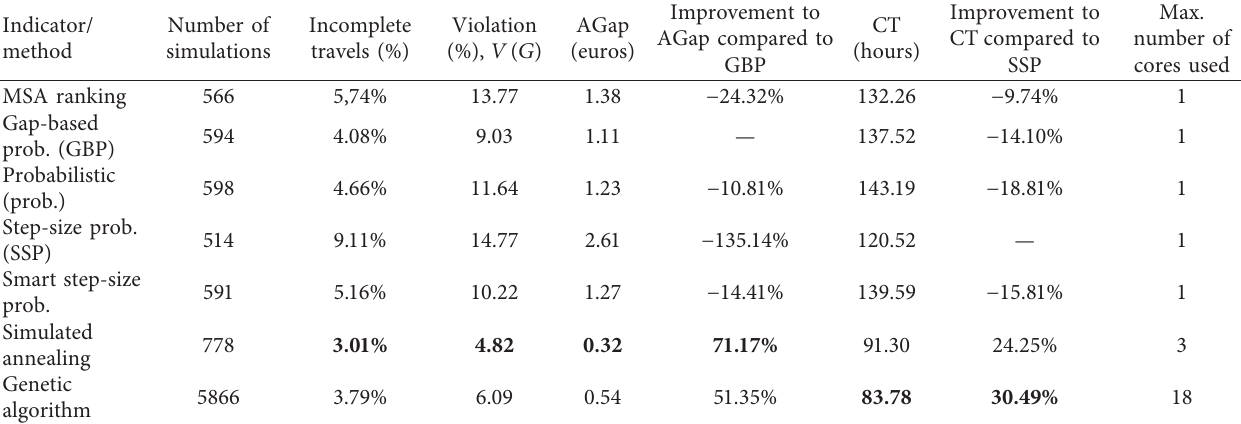
Table 3: Solution quality and performance indicators [CT: computation